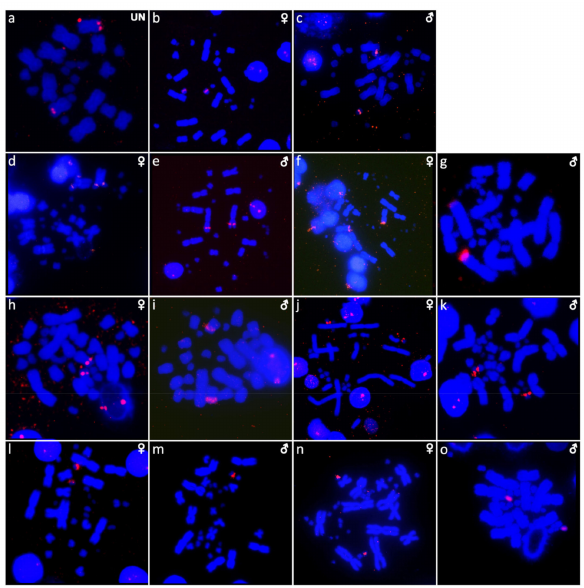
Figure 3. In situ hybridization with probe for 18S/28S rDNA sequences in Acontias percivali ( a ), Cy- clodomorphus gerrardii ( b , c ), Eutropis multifasciata ( d , e ), Platysaurus sp. 1 ( f ), Platysaurus sp. 2 ( g ), Scinco- pus fasciatus ( h , i ), Tiliqua gigas ( j , k ), Tiliqua scincoides ( l , m ), and Tracheloptychus madagascariensis ( n , o ). UN: sex not known.